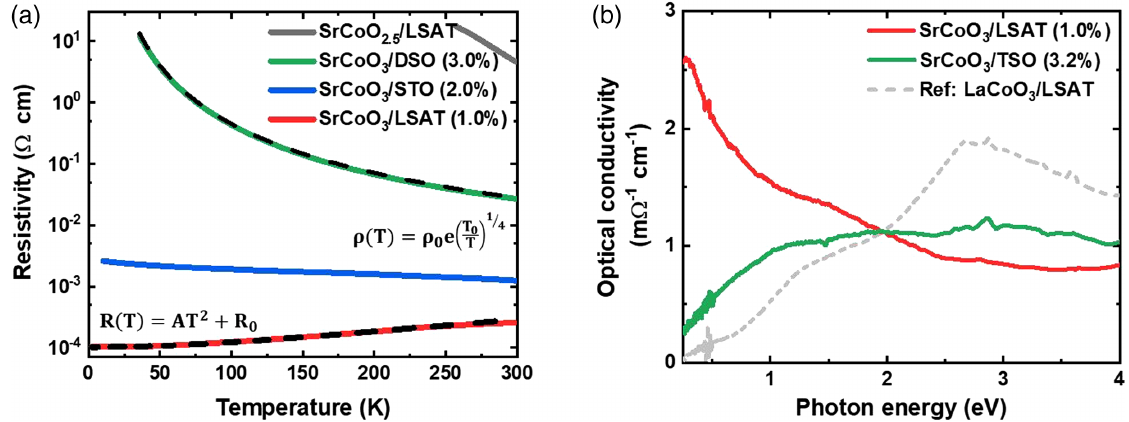
FIG. 3. Strain-induced metal-to-insulating transition in SrCoO 3 thin films. (a) Temperature-dependent resistivity of strained SrCoO 3 thin films grown on various substrates. The result of SrCoO 2 grown on LSAT is shown in gray as reference. The fitting of the resistivity . 5 results are shown in dotted lines. (b) The room-temperature optical conductivity spectra from SrCoO 3 thin films grown on LSAT (1.0%) and TSO (3.2%) substrates (we replaced the DSO substrate with TSO to avoid the absorption background from the DSO substrate.). The gray dotted line shows the result from a typically Mott insulator of LaCoO 3 (grown on LSAT substrate) for comparison